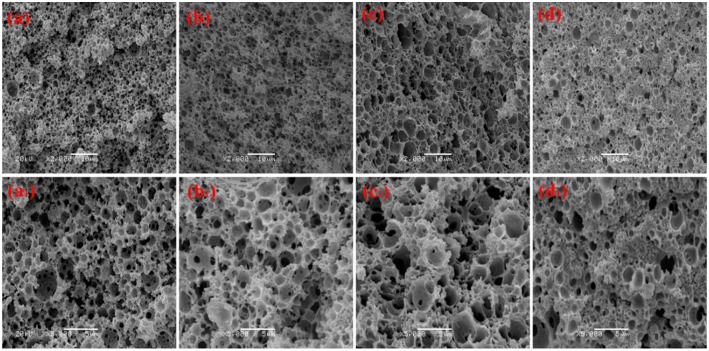
Effect of oil phase volume fraction for the CMC-g-PAM/MMT (a, a1) 50% (Sample 6); (b, b1) 40% (Sample 9); (c, c1) 30% (Sample 10); (d, d1) 20% (Sample 11). All of the prepared samples prepared with 5% of MMT and 4% of T-20.